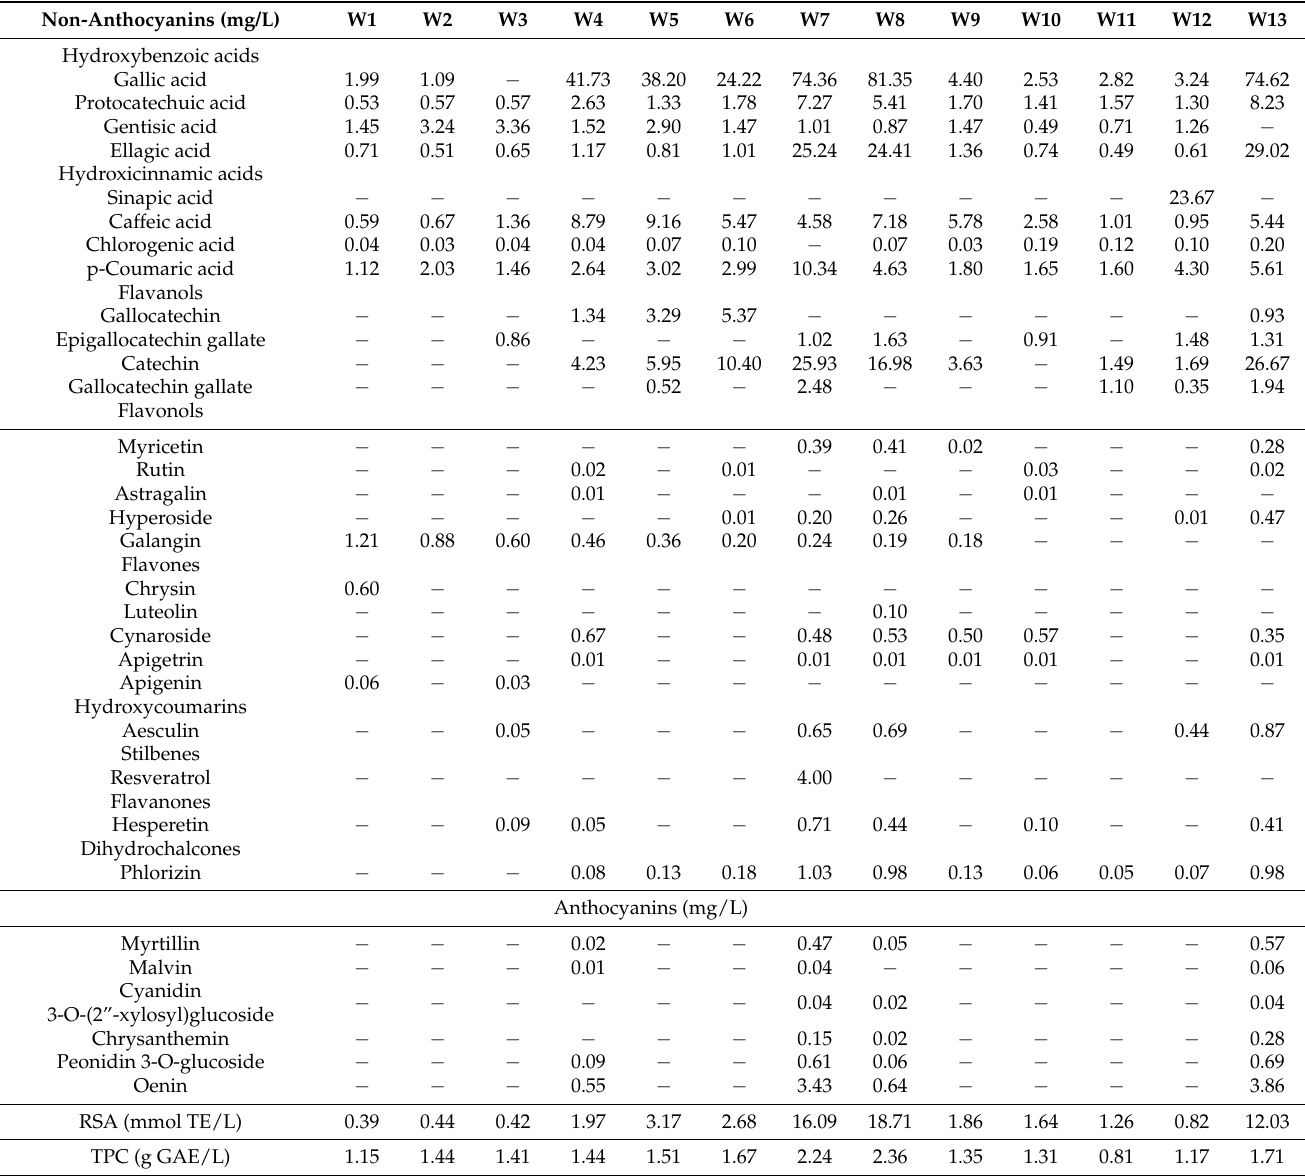
Table 3. Quantitative data on individual phenolic compounds (non-anthocyanins and anthocyanins) in Italian wines, radical-scavenging activity (RSA), and total phenolic content (TPC). Non-Anthocyanins